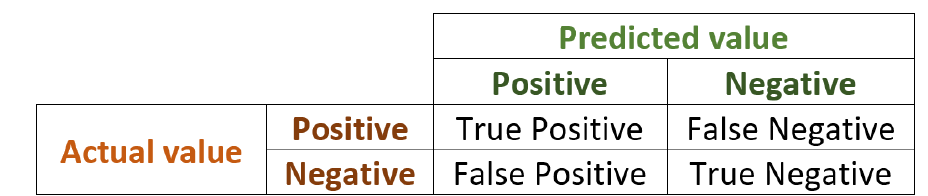
Figure 8. A general confusion